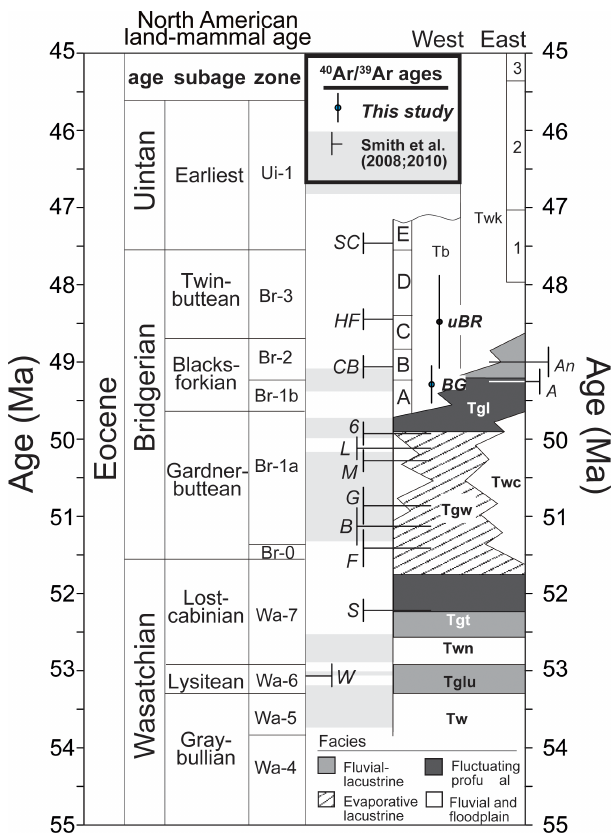
Figure 1. Age model of Eocene Wyoming. The North American land mammal age (NALMA) is shown for context. The upper Blue Rim is shown as “uBR”, the blue–green marker is depicted as “BG”, and both are shown with dots and error bars. Dates from M. E. Smith et al. (2008, 2010) are shown in perpendicular lines. The abbrevi- ations included are designated as follows. Green River